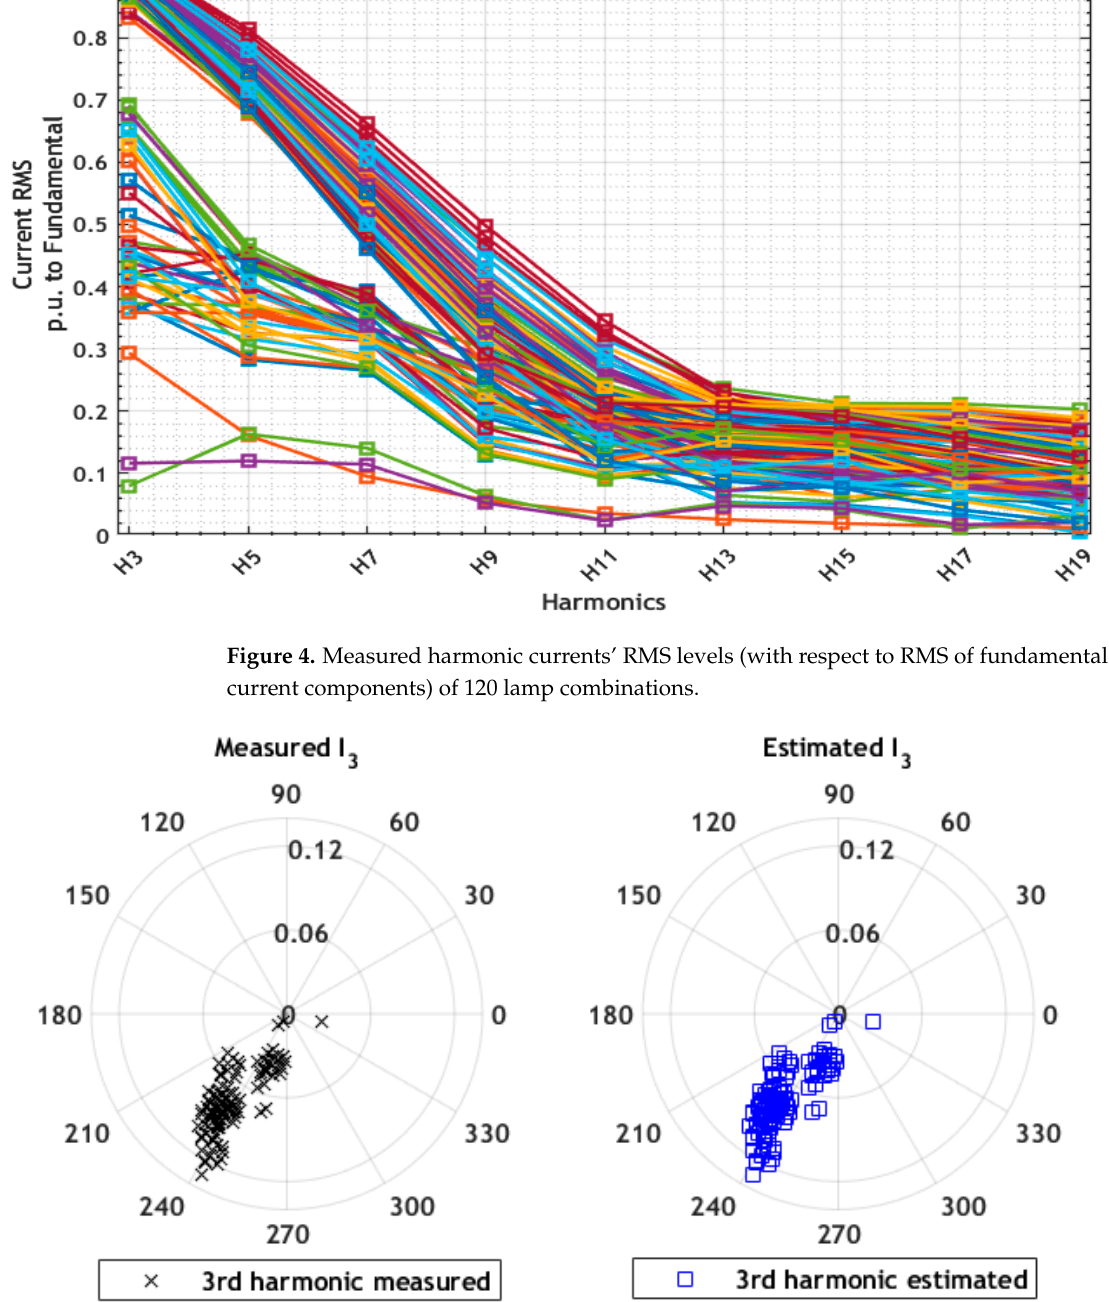
Figure 5. Third harmonic current vectors of all lamp combinations. The actual measurement data of every load combination are compared with the respective aggregated sum of individual harmonic currents of lamps that are present in the combination. Each point is the difference in the estimated and measurement results from an exclusive combination. The magnitude difference is represented as a percentage. The difference in the phase angles of measured and estimated harmonics is expressed in